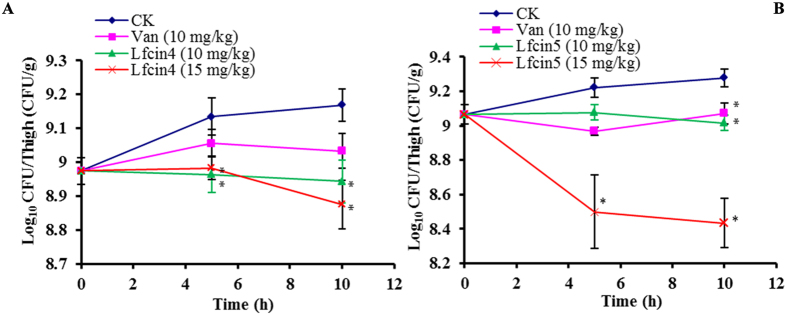
Efficacy of Lfcin4 and Lfcin5 against S. aureus ATCC25923 in the neutropenic murine thigh infection model.(A) Lfcin4 treatment. (B) Lfcin5 treatment. Control: mice treated with saline only; Van (10 mg/kg): mice treated with a single intravenous (tail) dose of vancomycin (10 mg/kg); Lfcin4/Lfcin5 (10 mgkg) and Lfcin4/Lfcin5 (15 mg/kg): mice treated with a single intravenous (tail) dose of 10 or 15 mg/kg Lfcin4 or Lfcin5, respectively. Results are presented as the mean ± SEM. Differences between groups were determined by one-way ANOVA followed by SPSS analysis (n = 4 per group). *p < 0.05 compared to the control group.